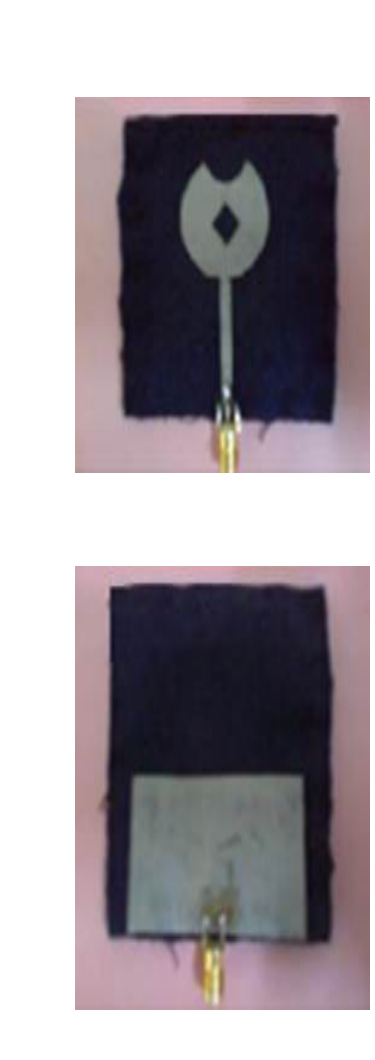
Figure 7: Hardware implementation of proposed antenna using textile substrate and conductive fabric (a) Front Face, (b) Back Face.